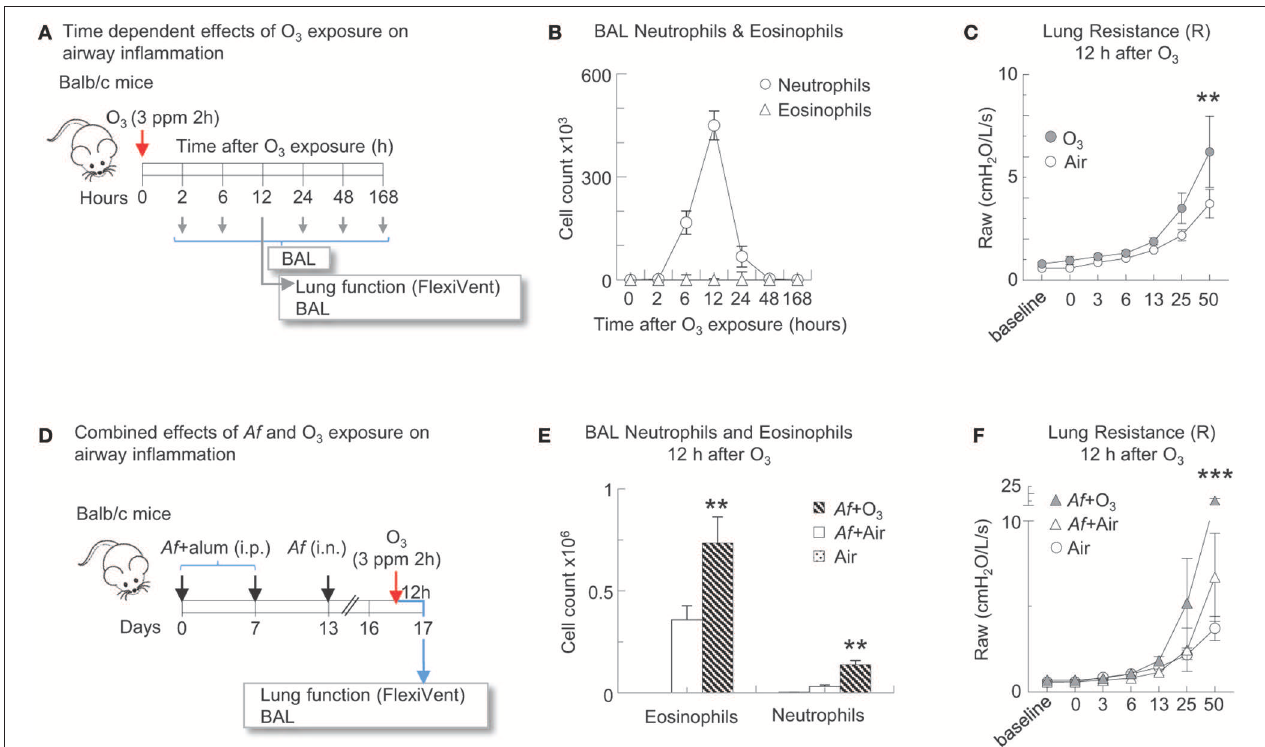
FIGURE 2 | O 3 induced airway inflammation and hyperreactivity and enhanced allergic airway changes in mice sensitized and challenged with Af . (A) Balb/c mice were exposed to air or 3 ppm O 3 for 2h and studied at the indicated time points for airway inflammation. 12h after O 3 exposure, lung function to methacholine was measured (Flexivent ® ) prior to BAL. (B) BAL neutrophils and eosinophils were quantified by differential cell counts on cytospin preparations multiplied by the total cell counts recovered from the BAL (Countess ® ). (C) O 3 exposed mice and air exposed controls were studied for methacholine responsiveness 12h later. Mean ± SEM of n = 6 ** p < 0.01 Two-way ANOVA with Tukey’s multiple comparison’s test (air vs. O 3 exposure). (D) Balb/c mice were sensitized to 20 µ g Aspergillus fumigatus ( Af ), with alum ( i.p. ) on days 0 and 7. On day 13, mice were challenged with 25 µ g Af ( i.n. ). 82h post- Af challenge, mice were exposed to air or 3 ppm O 3 for 2h, then 12h later (96h post- Af challenge), lung function was measured (Flexivent ® ) and BAL was harvested. (E) BAL neutrophils (live Ly6G + CD11b + cells) and eosinophils (live CD11c − Siglec-F + cells) were quantitated by FACS analysis. The absolute numbers of eosinophils and neutrophils were calculated by multiplying the percentage of cells determined by flow cytometric gating with the total numbers of cells/lung (Countess ® ). Mean ± SEM of n = 6; ** p < 0.01 Student’s t -test (air vs. O 3 ). (F) Lung function (airway resistance, Raw) was measured as indicated. Mean ± SEM of n = 6; *** p < 0.001 Two-way ANOVA with Tukey’s multiple comparison’s test (air vs.